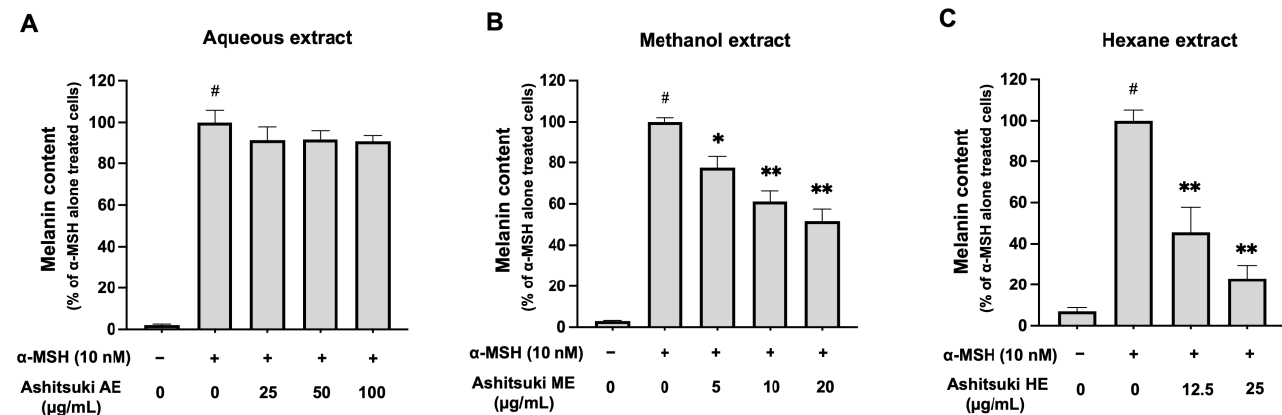
Figure 6. Effect of N. verrucosum ( ashitsuki ) extracts on melanin synthesis in B16F1 melanoma cells. B16F1 melanoma cells were treated with N. verrucosum aqueous ( A ), methanol ( B ), and hexane ( C ) extracts for 3 d in the presence of 10 nM α -MSH. After treatment, intracellular melanin content was measured as described in the materials and methods section. Results are represented as percentages of the α -MSH-alone-treated control group, the data are shown as mean ± SEM of three separate experiments. # p < 0.05 versus the control group. * p < 0.05, and ** p < 0.01 versus the α -MSH-alone- treated control group.